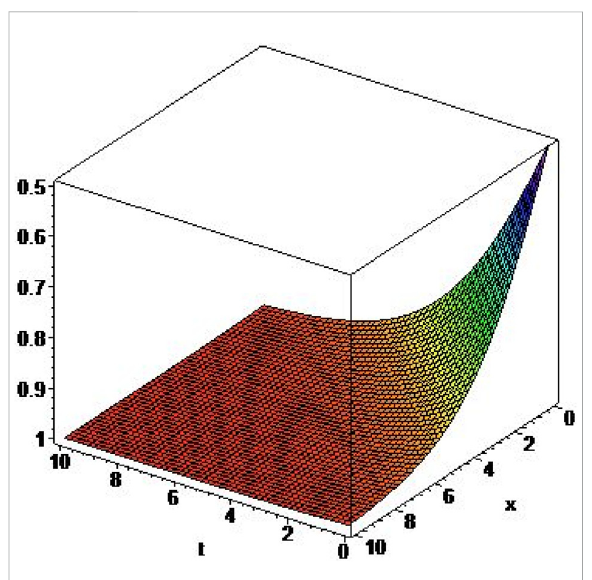
FIGURE 2 Figure of u5 in (Eq. 4.16) with a0 = 1/2, 0 < t < 10, and 0 < x < 10.